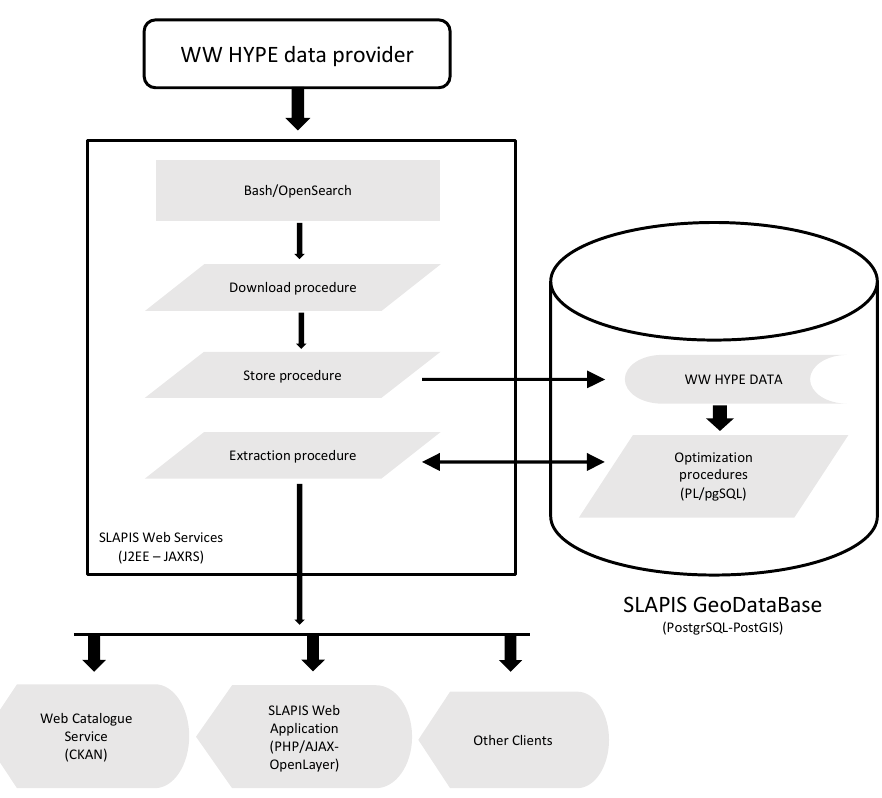
Figure 8. WWH forecasts data flow in SLAPIS spatial data infrastructure.